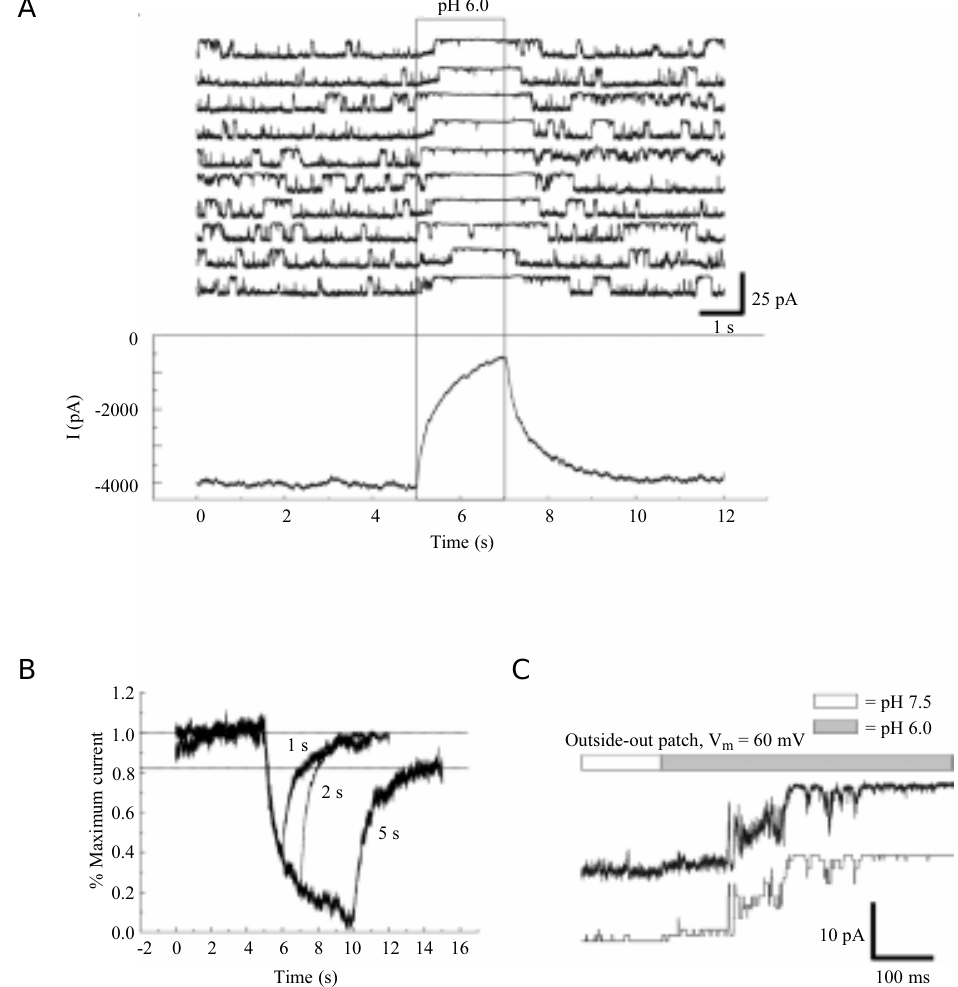
Outside-out patch, V m = 60 mV1 s